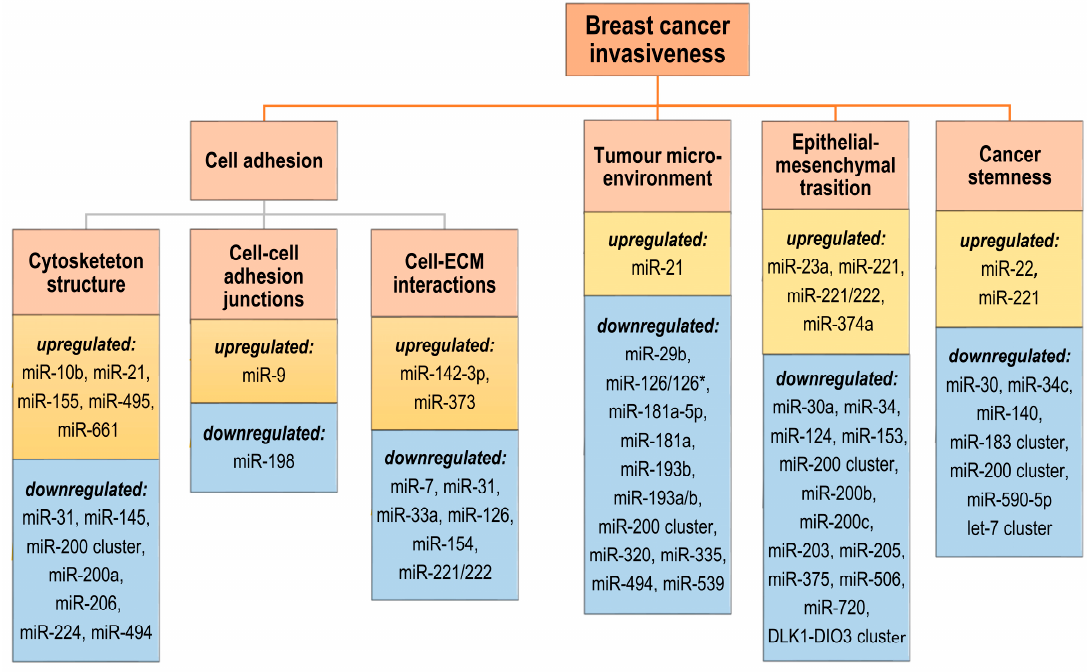
Figure 1. Up-regulated and down-regulated microRNA expression profiles in specific processes associated with breast cancer invasiveness and stemness. ECM, extracellular matrix. Note: miR-126*, the partner to miR-126 that is derived from the same transcript, had a similar expression pattern [127].